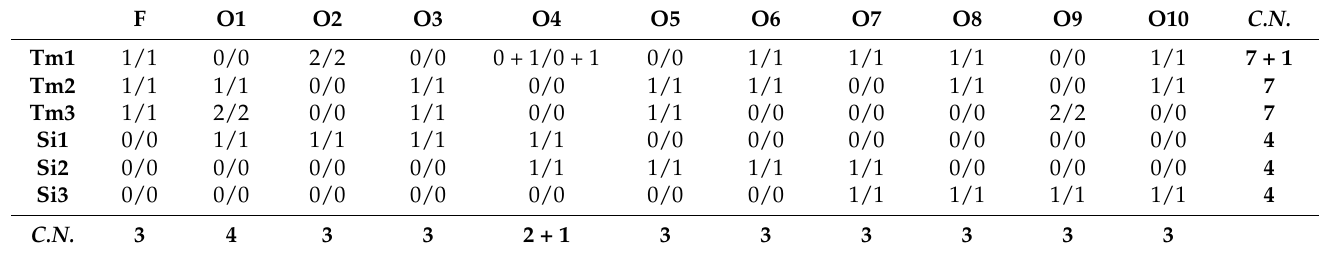
Table 4. Motifs of mutual adjunction [23,24] for the Tm 3 F[Si 3 O 10 ]